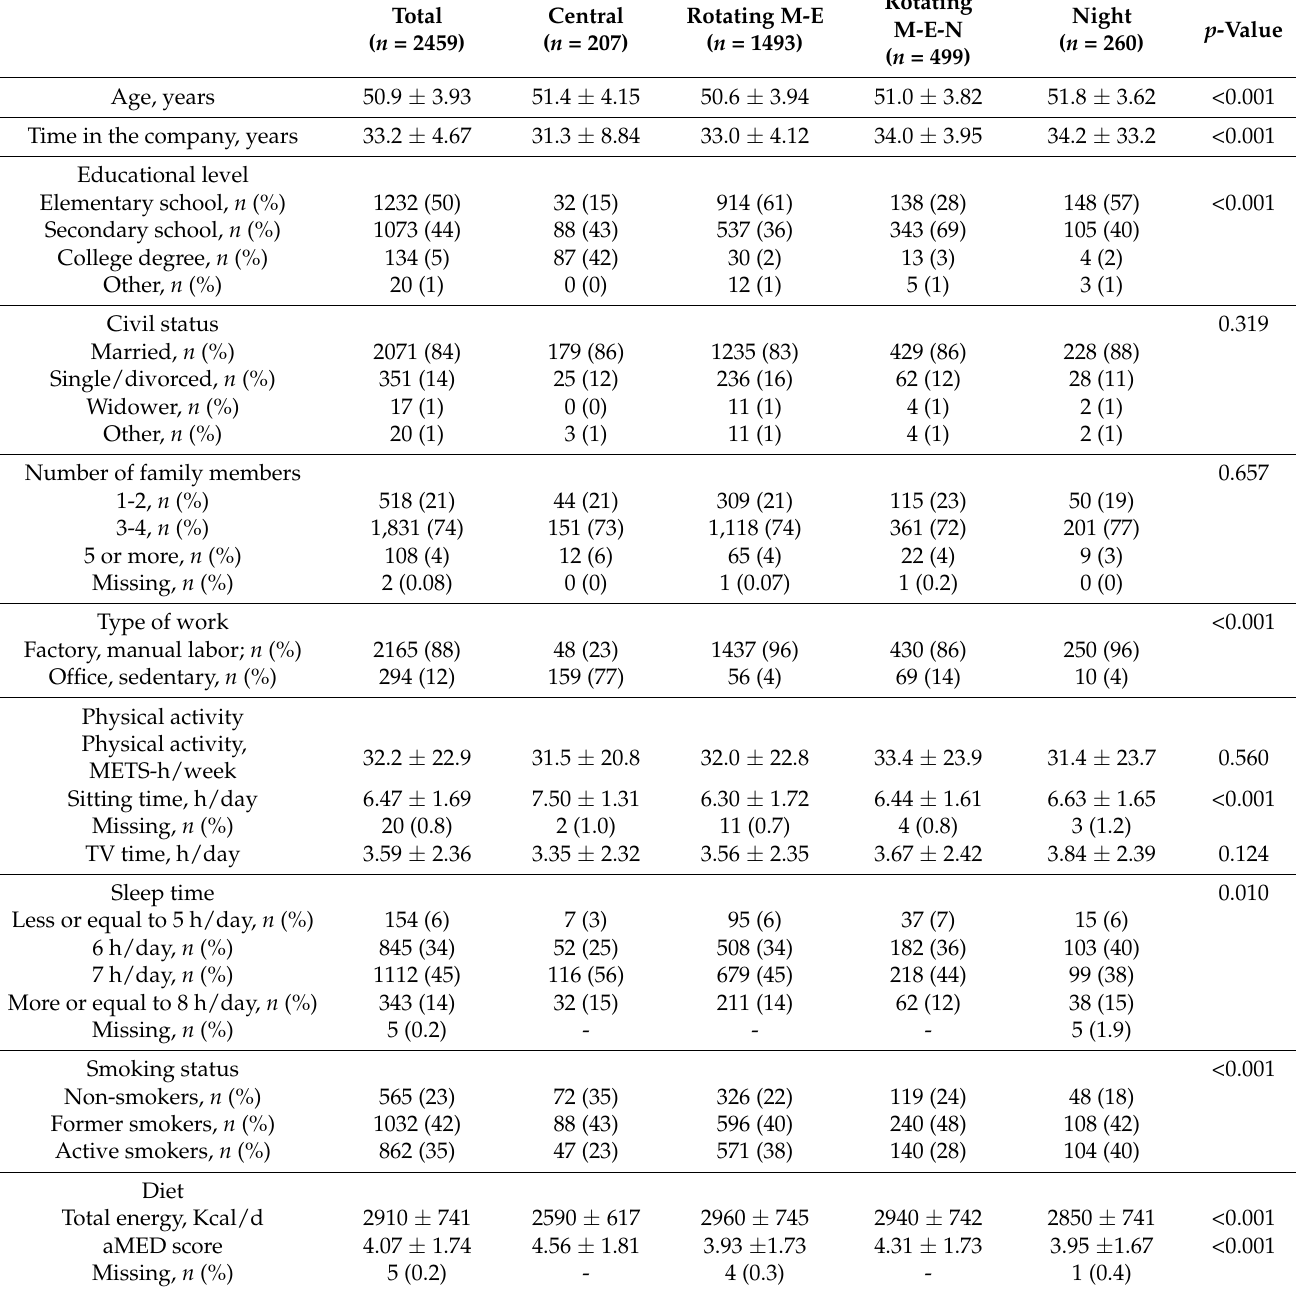
Table 1. Demographics, lifestyle- and job-related characteristics of the AWHS participants according to work